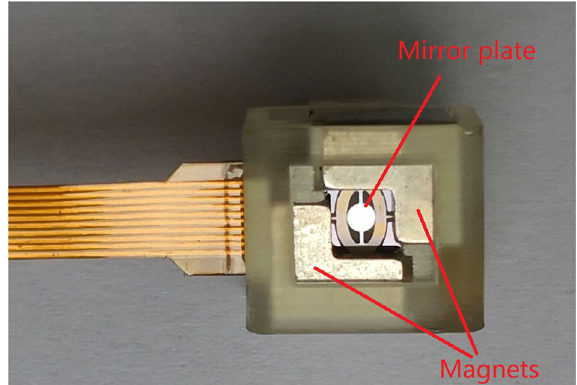
Figure 1. Electromagnetic micro-mirror.